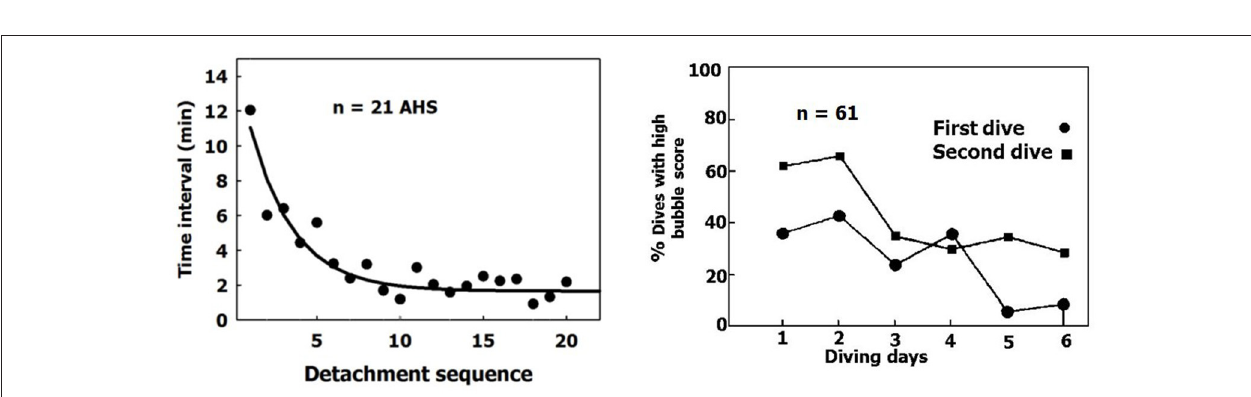
FIGURE 11 | Distribution of bubblers—non bubblers. (A) In blood vessels of sheep. (B) (data compiled from Lambrechts et al., 2013) and (C) (data compiled from Cialoni et al., 2015 with permission), in divers.